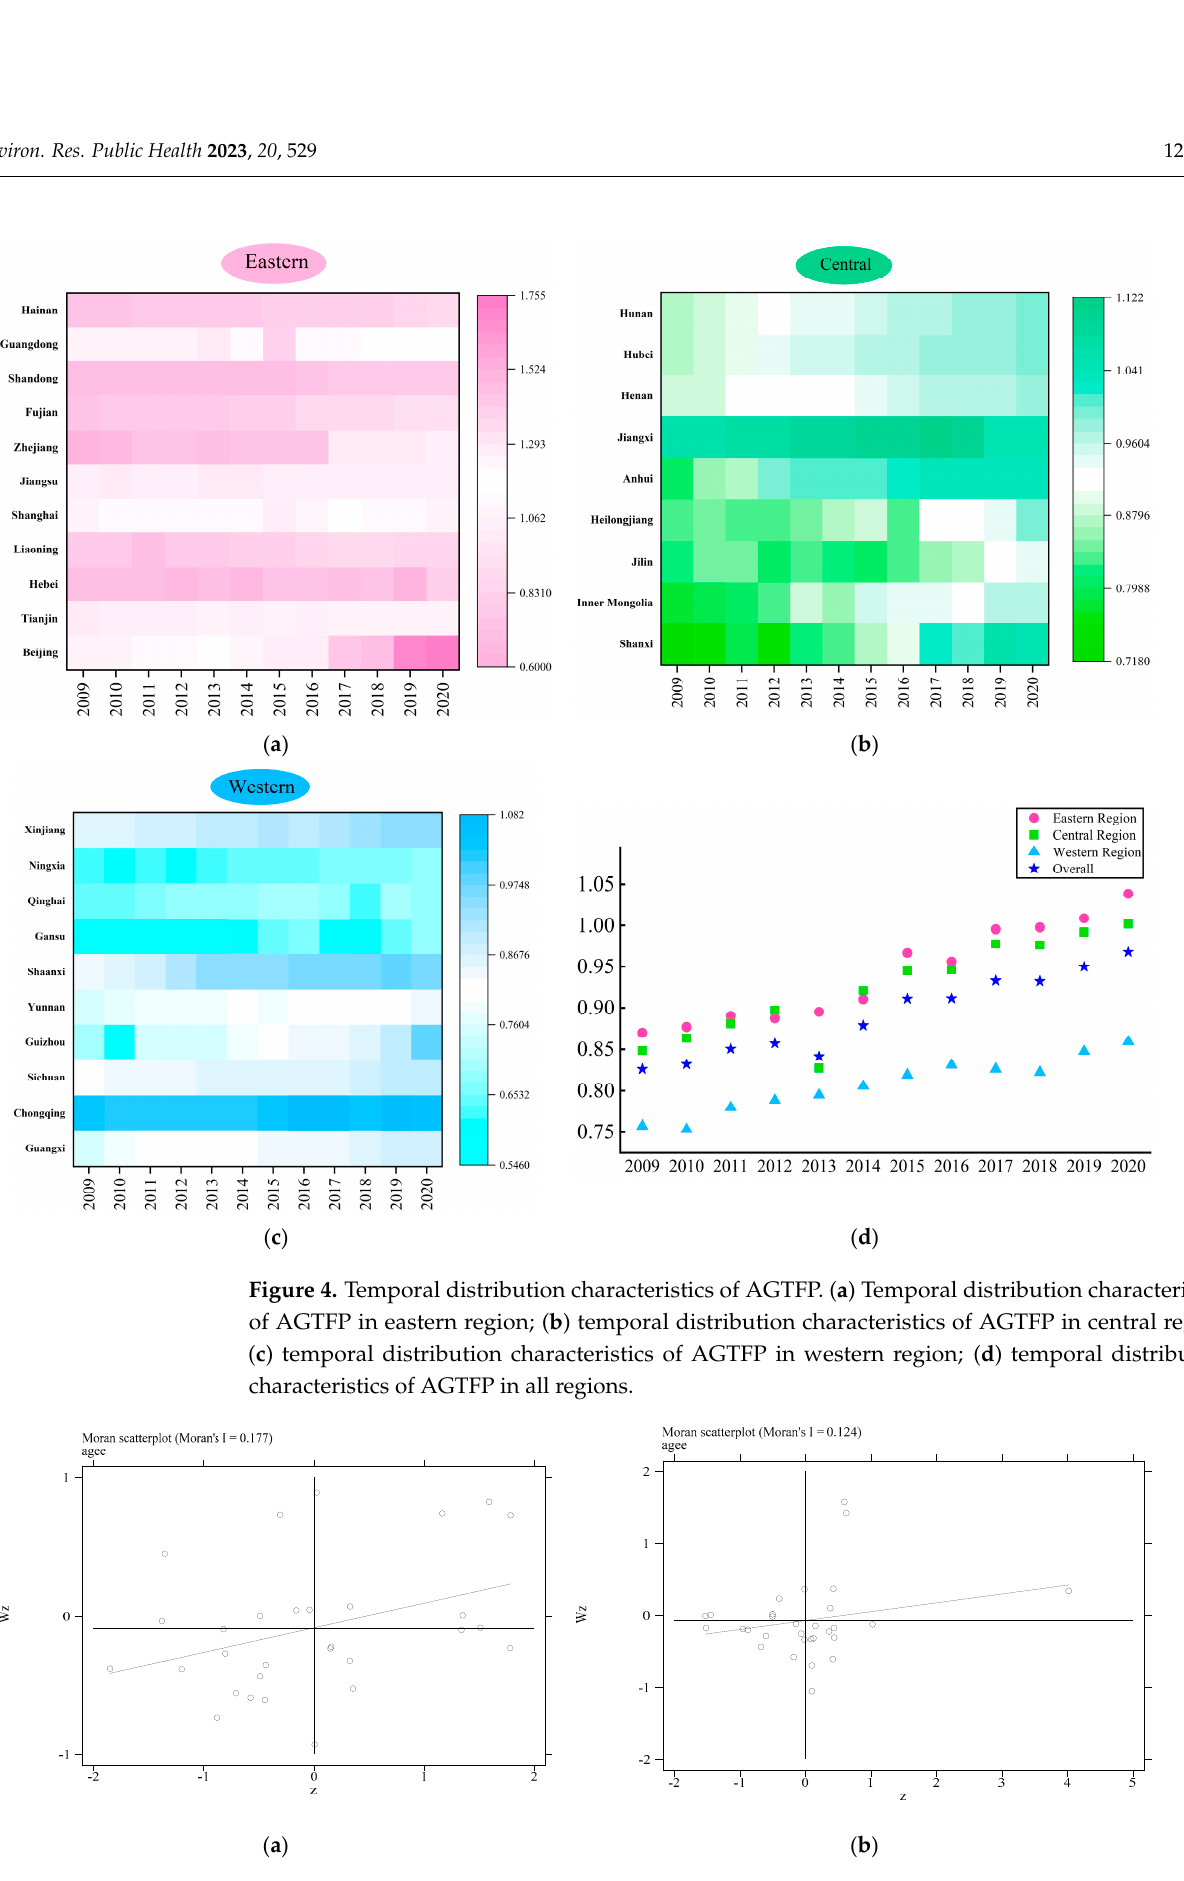
Figure 5. The Moran scatter diagram of AGTFP in 2009 and 2020. ( a ) The Moran scatter diagram of AGTFP in 2009; ( b ) the Moran scatter diagram of AGTFP in 2020.